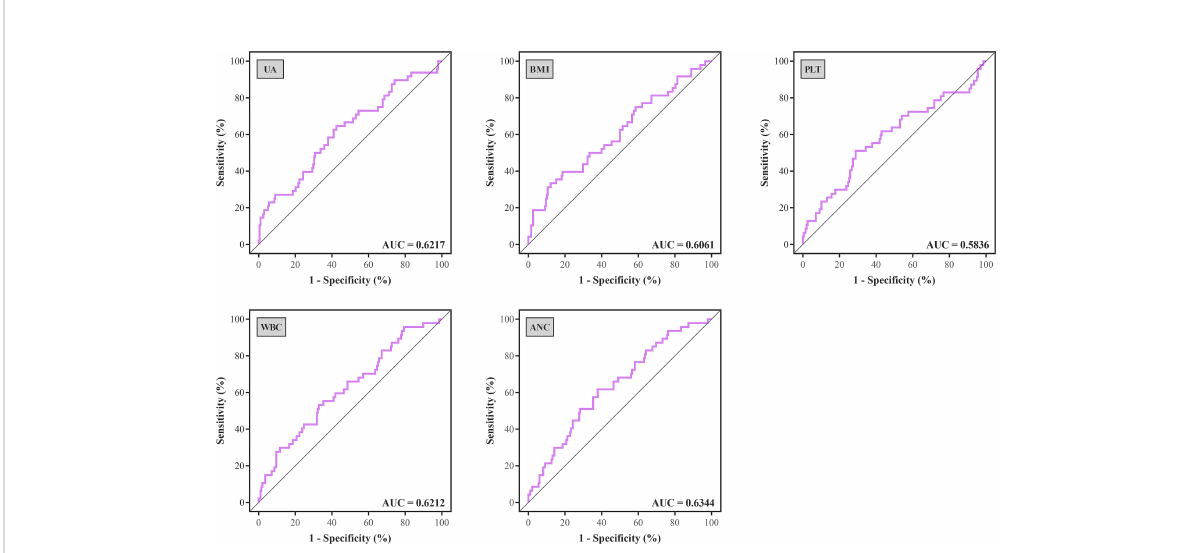
FIGURE 1 ROC curves were generated to determine the optimal cutoff value of UA, BMI, PLT, WBC, and ANC for treated rejection. ROC, receiver operating characteristic; AUC, area under the curve; UA, uric acid; BMI, body mass index; PLT, platelet; WBC, white blood cell; ANC, absolute neutrophil count.